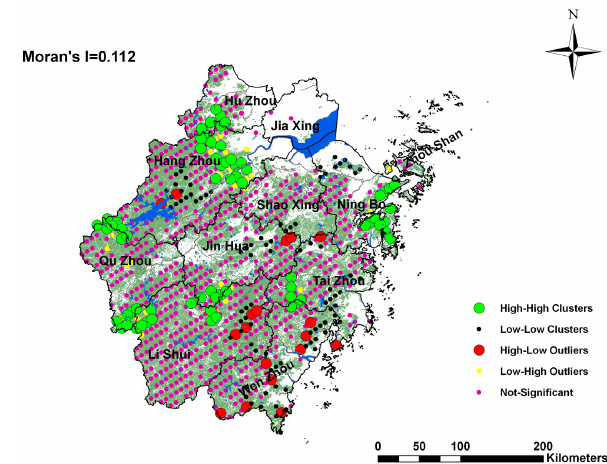
Fig. 5. Spatial clusters and spatial outliers map of FLC density. Fig. 5 Spatial clusters and spatial outliers map of FLC density